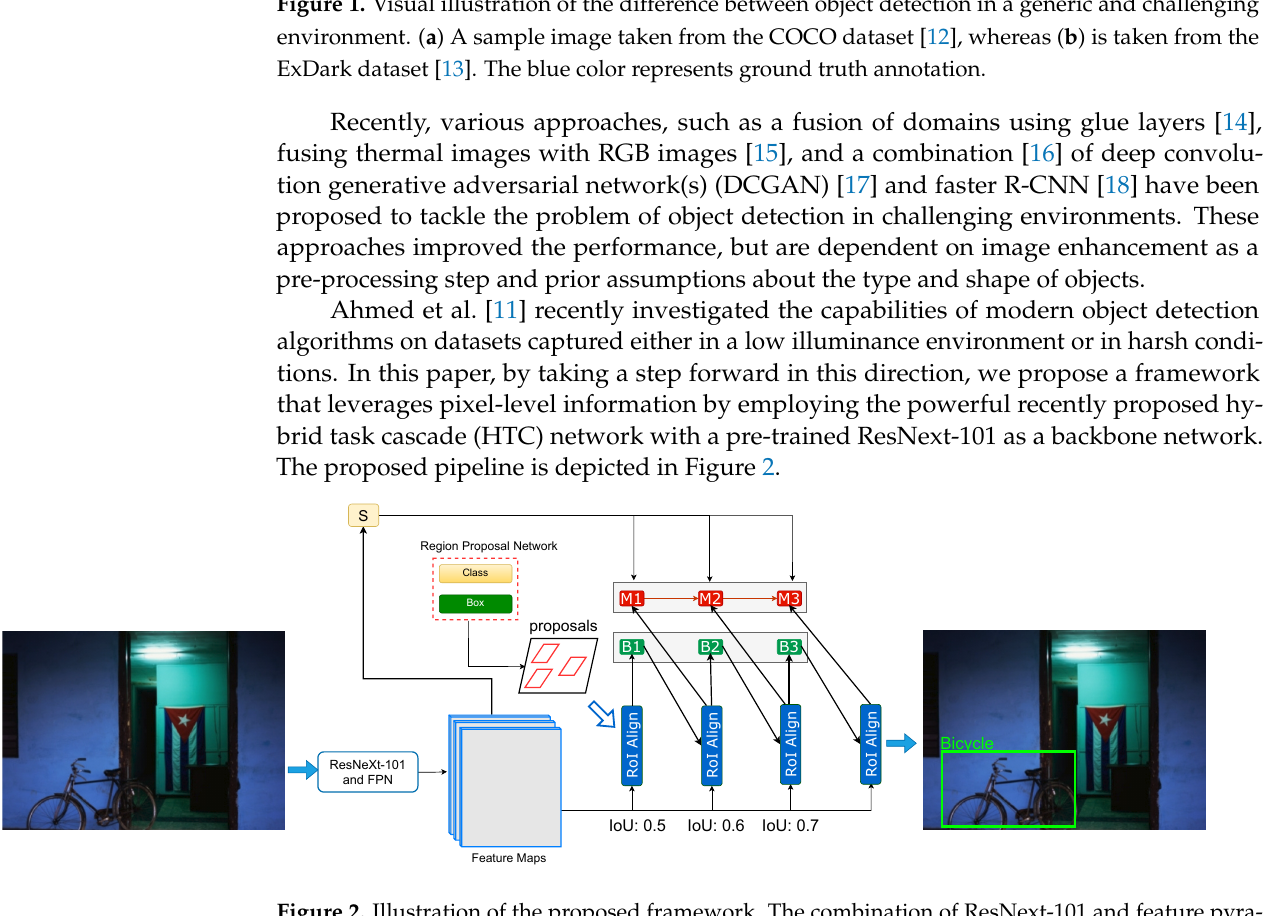
Figure 2. Illustration of the proposed framework. The combination of ResNext-101 and feature pyra- mid network (FPN) extracts the spatial features from the input image on various scales. The features are propagated to the region proposal network to generate candidate regions. The cascaded R-CNN block further refines the bounding box and masks prediction by leveraging semantic features in the second stage. The optimized proposal features from the last stage are propagated to compute final